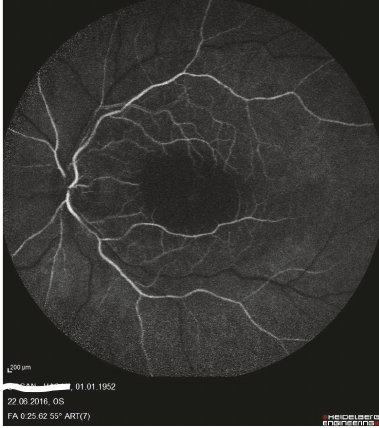
Figure 3: Early phase of fundus fluorescein angiography.